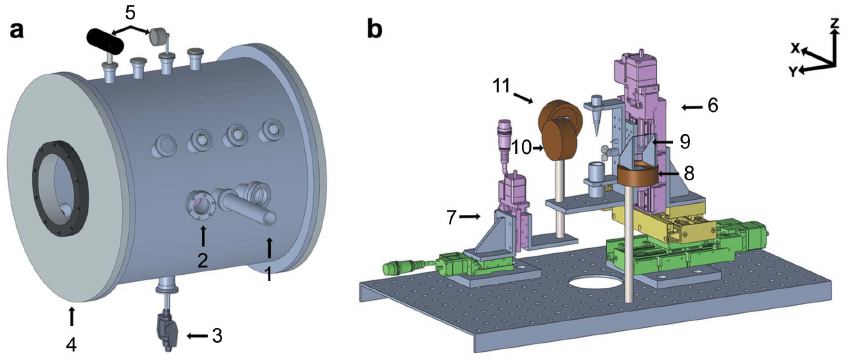
Figure 3 Schematics of ( a ) the X-ray absorption spectroscopy (XAS) chamber and ( b ) its inner components. The key components are marked with numbers: (1) the X-ray entrance port, (2) the laser entrance port, (3) the inlet and outlet for the liquid sample, (4) a hinged door, (5) two pressure meters (one digital and one analog), (6) the sample stage with XYZ translation stages [with a liquid nozzle, a pinhole, a Y-Al garnet (YAG) crystal, and a pinhole], (7) the detector stage with YZ translation stages, (8) a photodiode for recording incident flux, (9) 800 nm-thick Al foil as the X-ray scatterer for incident flux measurement, (10) an avalanche photodiode for measuring fluorescence from the sample, (11) a photodiode for measuring transmittance signals through the sample. The X-ray-free- electron laser (XFEL) beam direction follows the